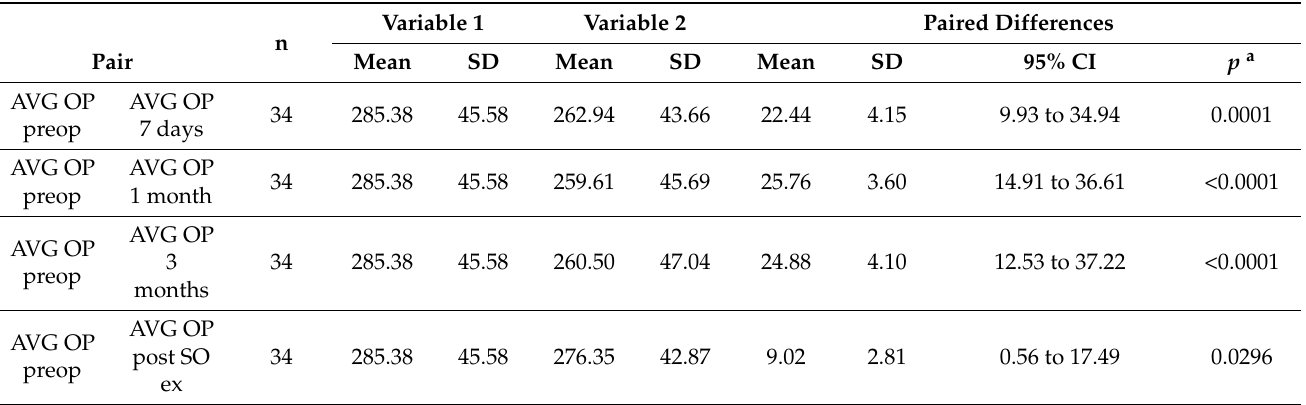
Table 6. Average macular thickness cube—AVG ( µ m) in PPV SO operated